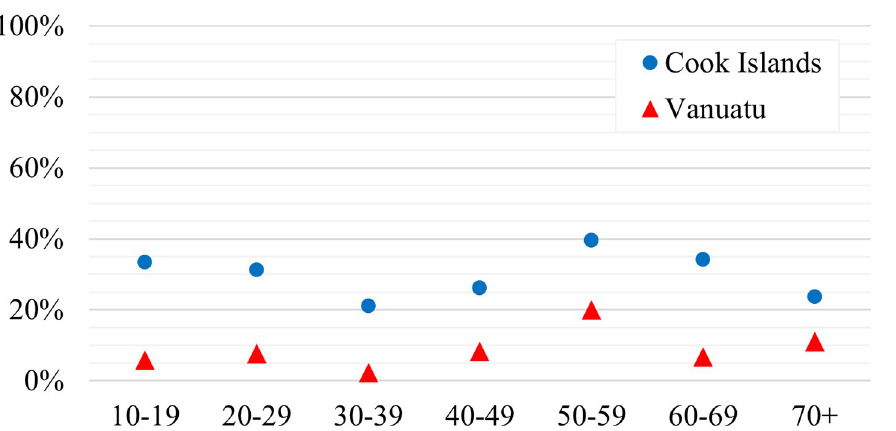
Fig 3. Positive ELISA test results by 10 years age groups (excluding age group 0–9